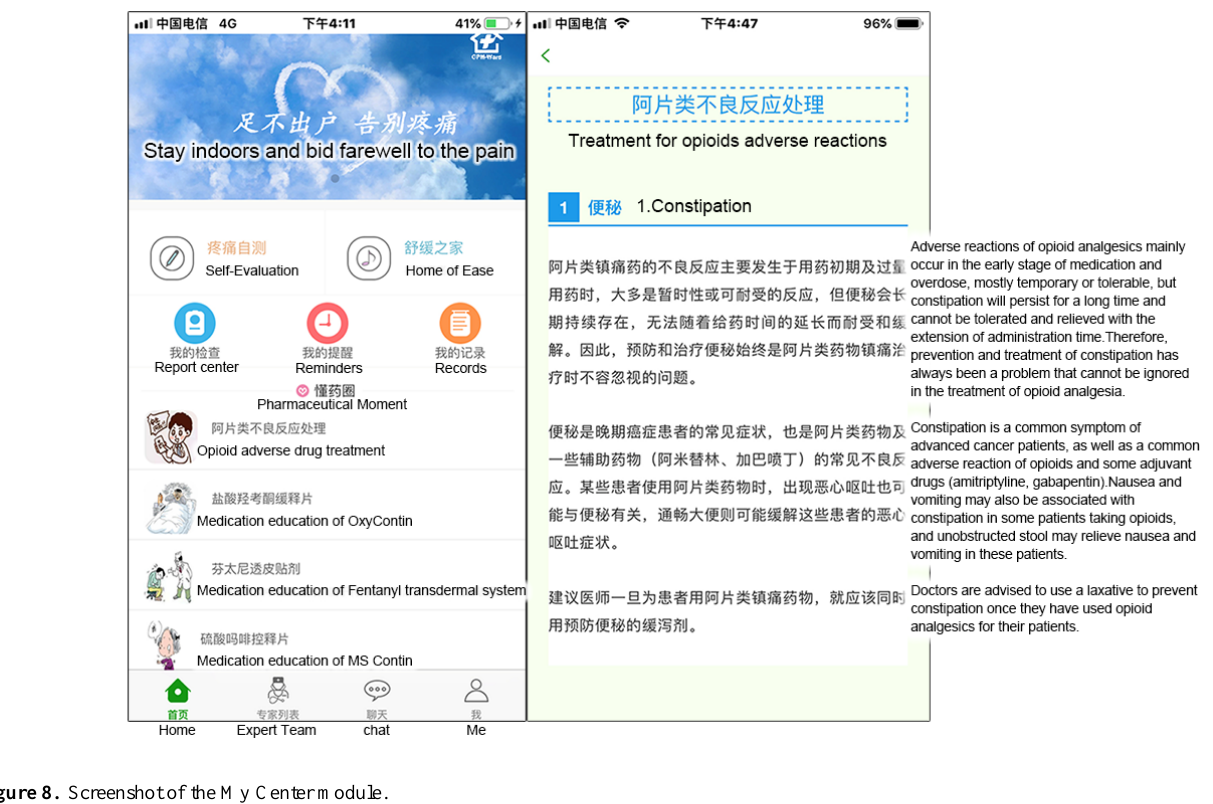
Figure 7. Screenshot of the pharmaceutical moment module.